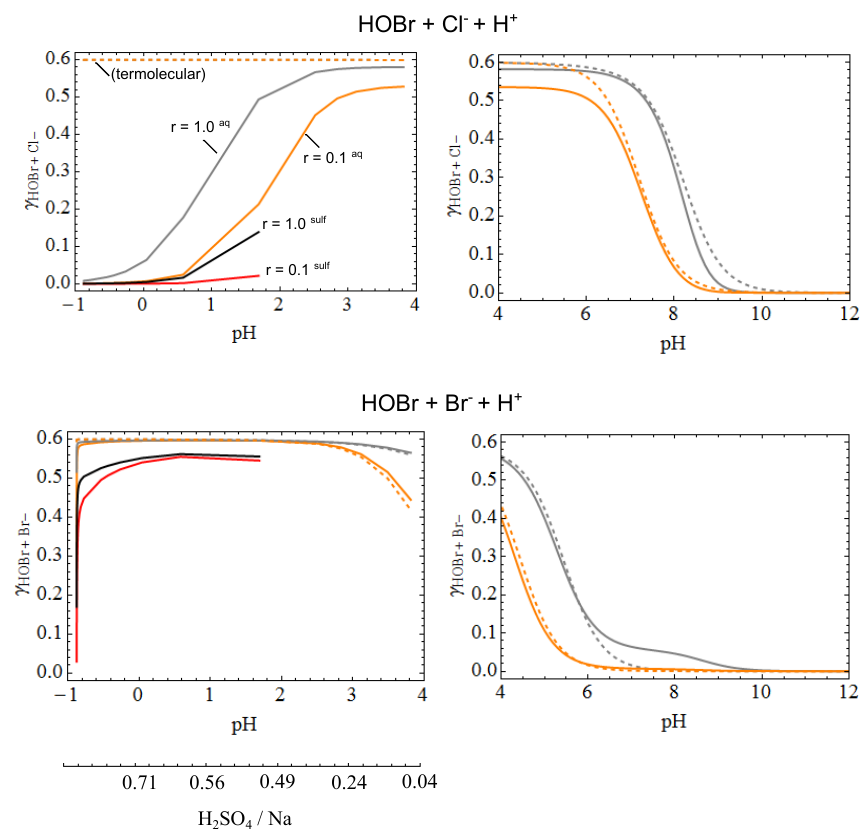
Figure 3. Variation in the HOBr uptake coefficient with pH, for reaction of HOBr with (upper) Cl − and (lower) Br − on H 2 SO 4 -acidified sea-salt aerosol. Grey and orange lines denote uptake onto 1 and 0.1µm radius particles, respectively. Black and red lines denote uptake onto 1 and 0.1µm radius particles calculated using H ∗ and D l parameterisations for sulfuric acid (rather than water), shown only for H 2 SO 4 :Na ratios greater than 0.5. Relative humidity is set to 80% and Na concentration 1.3 × 10 − 7 molesm − 3 (equivalent to a PM 10 of 10µgm − 3 in the marine environment, Seinfeld and Pandis, 1998). For comparison, uptake coefficients calculated assuming termolecular kinetics are also shown (dashed